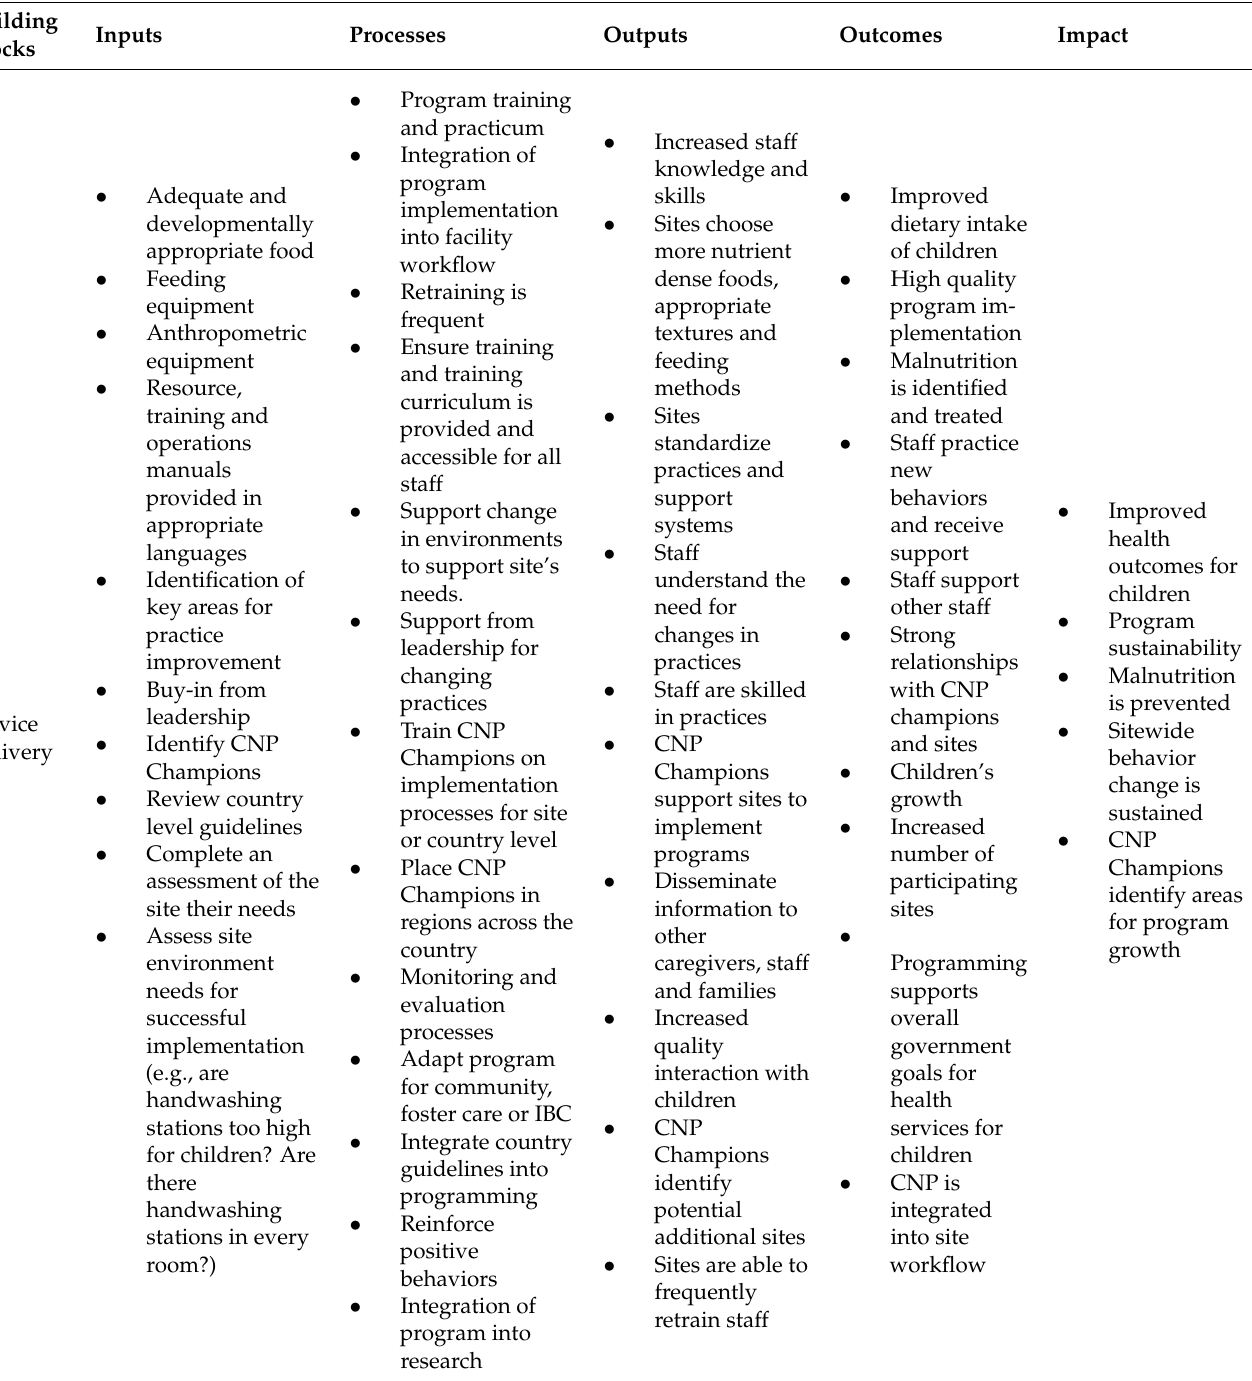
Table A3. Summary of the Implementation Process of the Child Nutrition Program based on the WHO’s Health System’s Framework and Monitoring and Evaluation of Health Systems